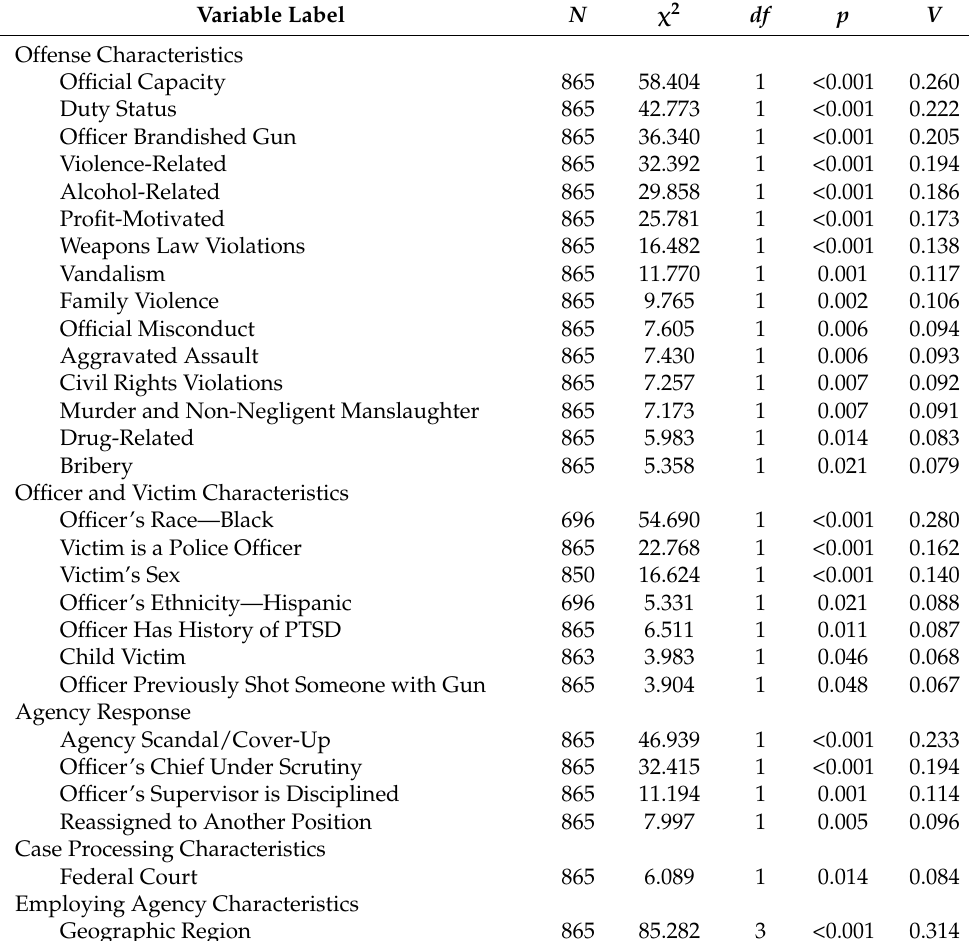
Table 3. Victim race bivariate